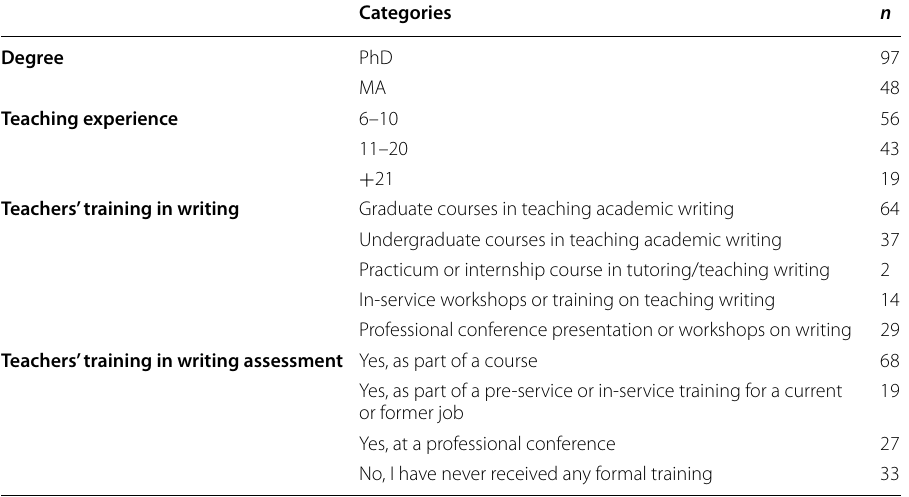
Table 1 Demographic information of the participants in the study